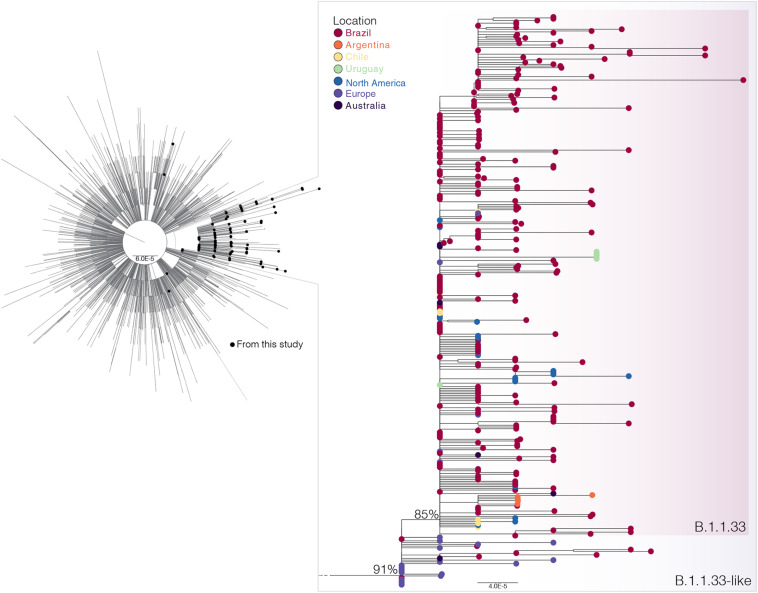
Phylogenetic relationships of SARS-CoV-2 B.1.1 Brazilian and global strains. Maximum likelihood (ML) phylogenetic tree of 190 B.1.1 Brazilian genomes obtained in this survey (black circles) along with 3,053 B.1.1 international reference sequences from the GISAID database. The zoomed view shows the clusters B.1.1.33-like and B.1.1.33. Tip circles are colored according to the sampling location. Only node supports (aLRT) above 70% are shown. Shaded boxes highlight the position of clusters B.1.1.33-like and B.1.1.33. Tree was rooted on midpoint, and branch lengths are drawn to scale with the bars at the bottom indicating nucleotide substitutions per site.